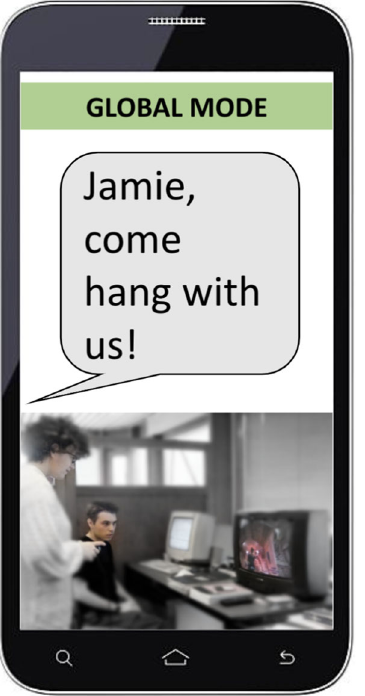
Fig. 2 Mockup of a Phone App that illustrates the implementation of the global fi lter for use by those wanting support with global salience. The phone interface shows a fi ltered image, a banner that states “ global fi lter ” to indicate the picture has been fi ltered and a text box that mimics